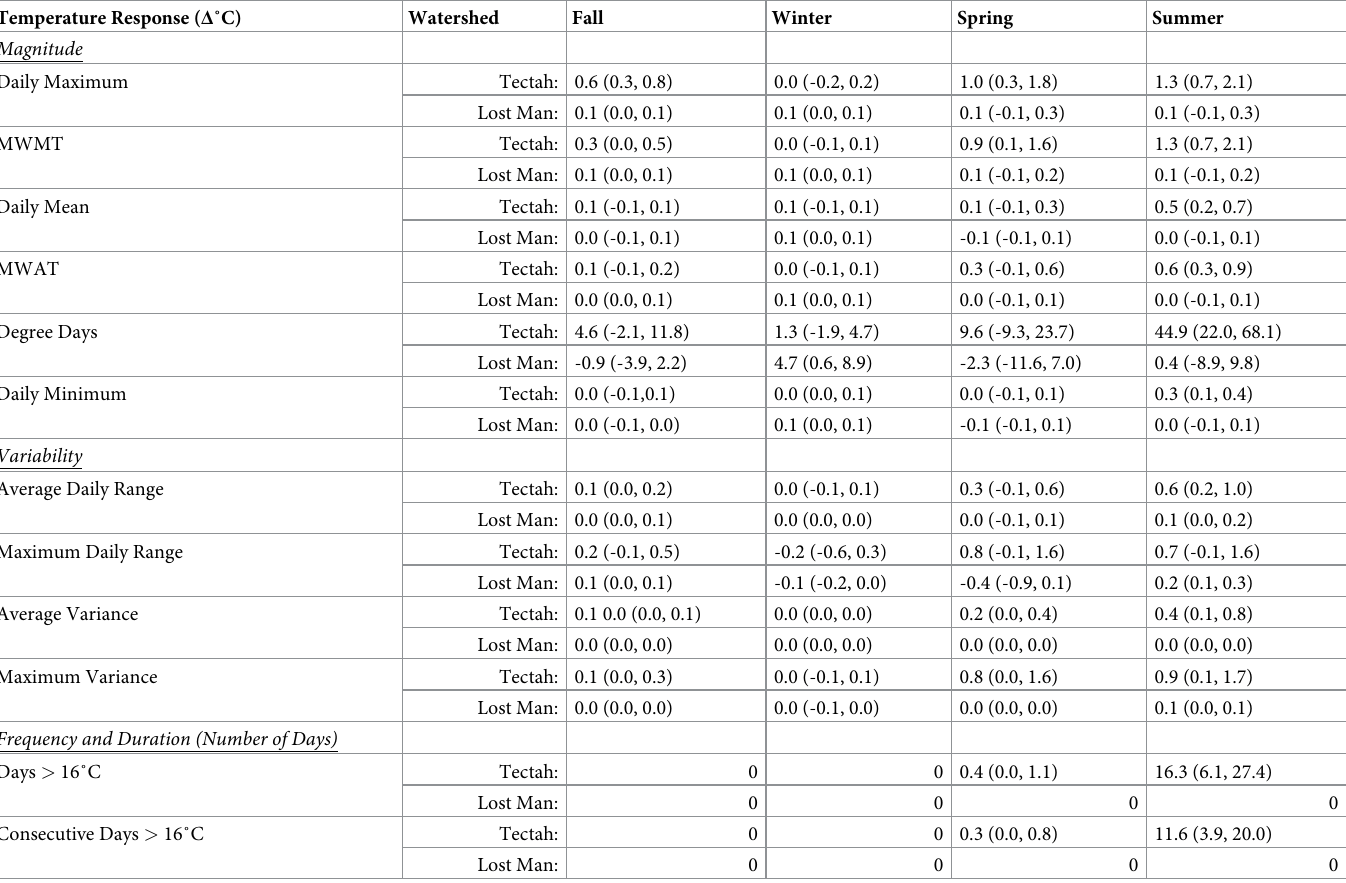
Table 3. Stream thermal regime responses in downstream